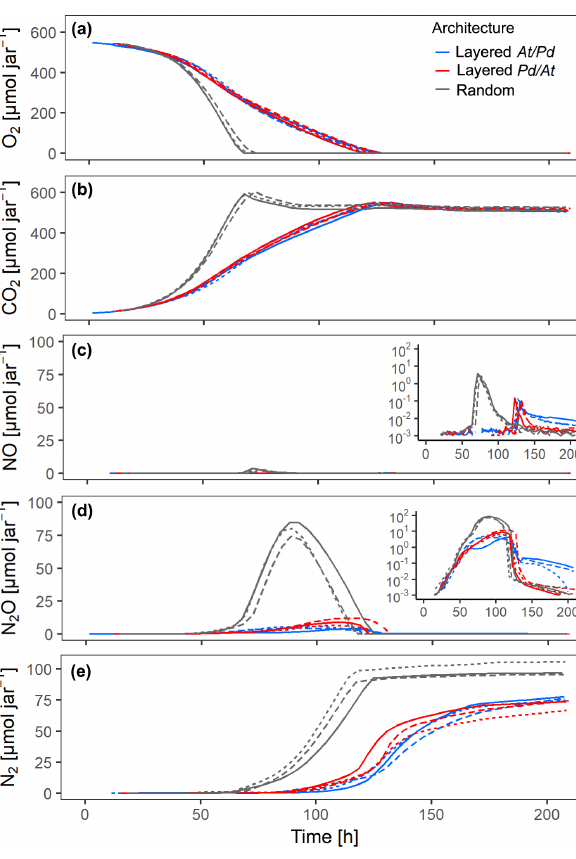
Figure 3. Gas kinetics in all treatments at medium saturation in the sand (60%WFPS) and an initial O 2 concentration of 20% in the headspace for three different hotspot architectures containing a total of 100 hotspots, in which the hotspots either had maximum separa- tion distance (random) or were densely packed in layers either with all At hotspots (layered At–Pd ) or all Pd hotspots (layered Pd–At ) in the upper layer: (a) O 2 , (b) CO 2 , (c) NO, (d) N 2 O, (e) N 2 . Data are only shown for the first 210h of the incubation period (300h total). Different line styles represent